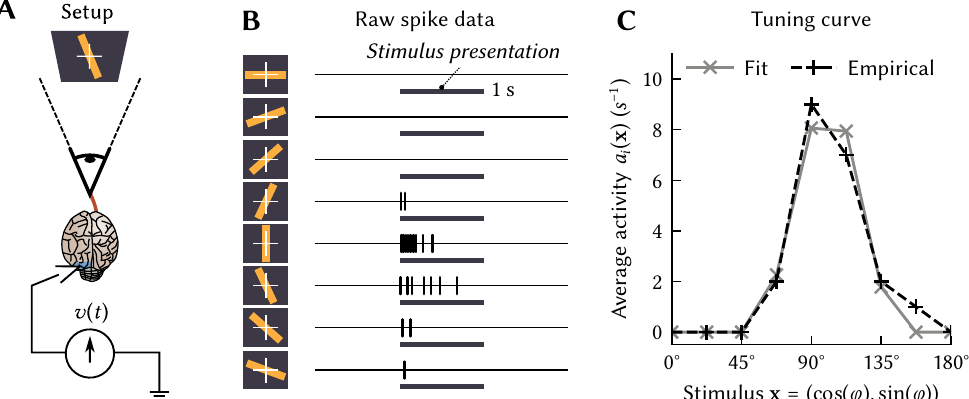
Figure 1. Illustration of the original Hubel and Wiesel experiment [15]. ( A ) Measuring the activity a i of a neuron in response to a bar of light projected onto a screen. ( B ) The neuron produces different levels of activity depending on the orientation of the bar of light x (data from [15]). ( C ) Plotting the activity a i ( x ) (dashed line) and a least-squares fit G [ J ( x )] (gray line; G is a LIF response